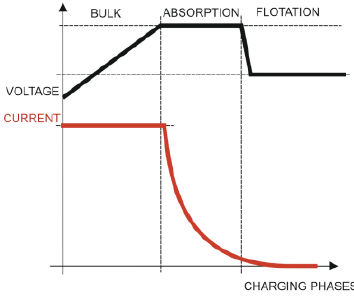
Figure 5. Batteries’ three-phase charge process.